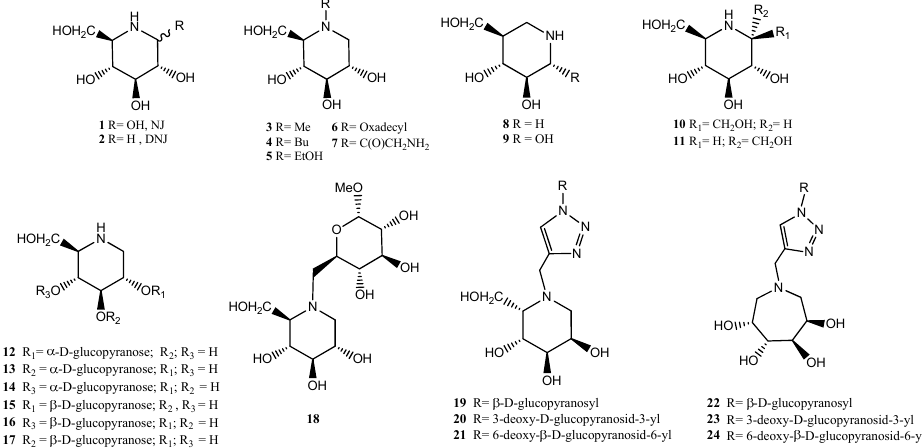
Figure 1. Examples of polyhydroxylated piperidine and azepane iminosugars reported, some of them displaying glucosidase inhibition.